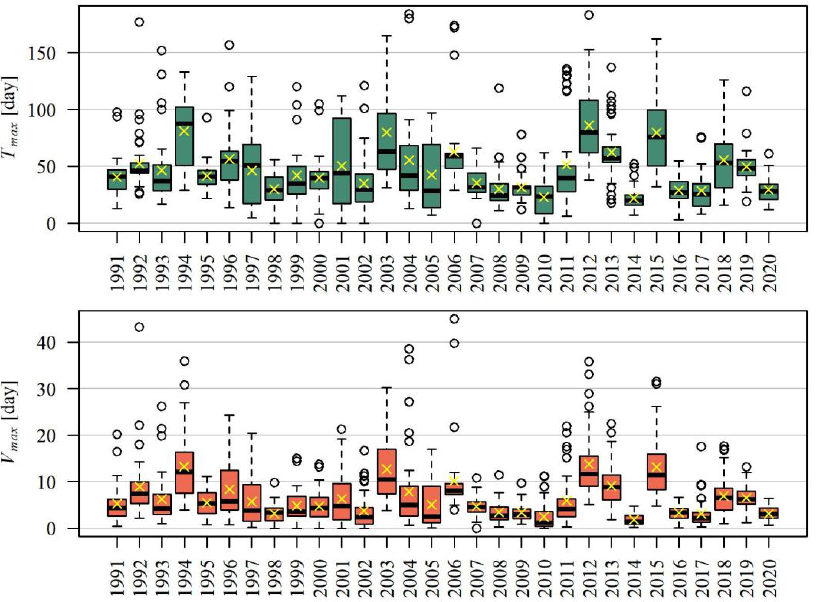
Figure 4. Distribution of the duration T max and volume V max of the maximum drought in the hydrological period between 1991 and 2020, in the studied area.